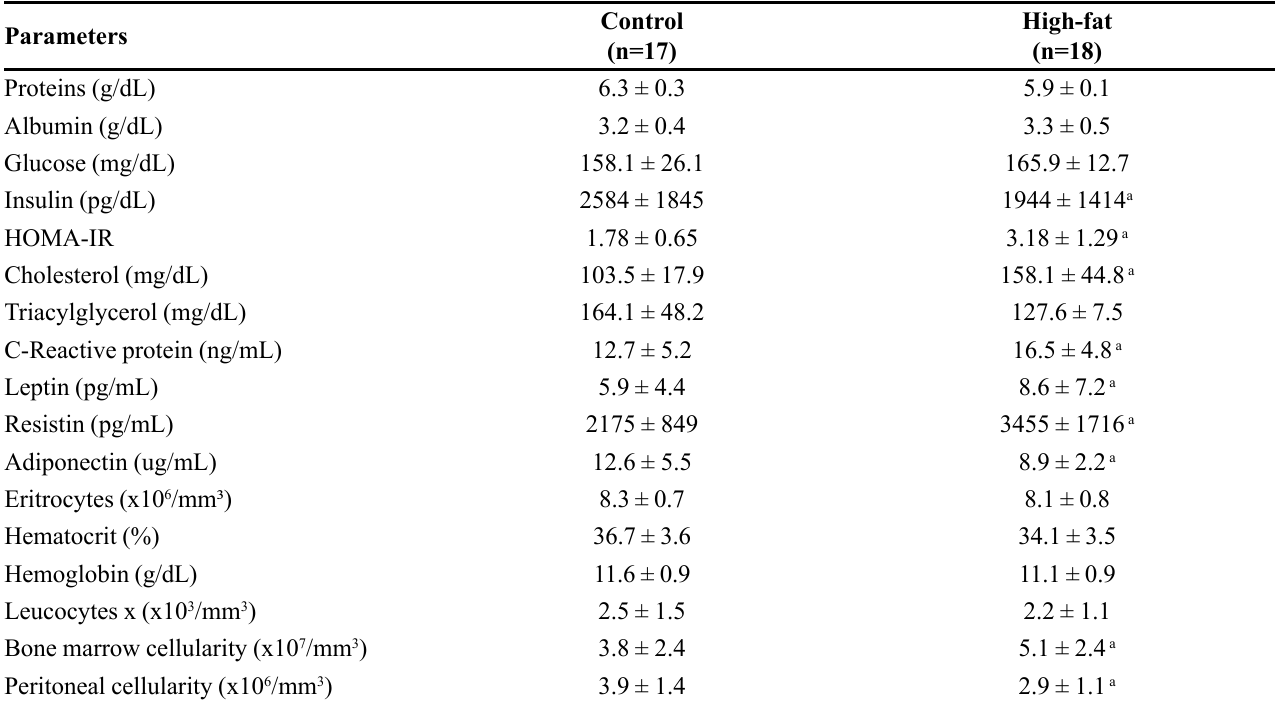
TABLE III - Inflammatory biomarkers (in blood serum) and blood cell counts of the Control and High-fat groups of Swiss